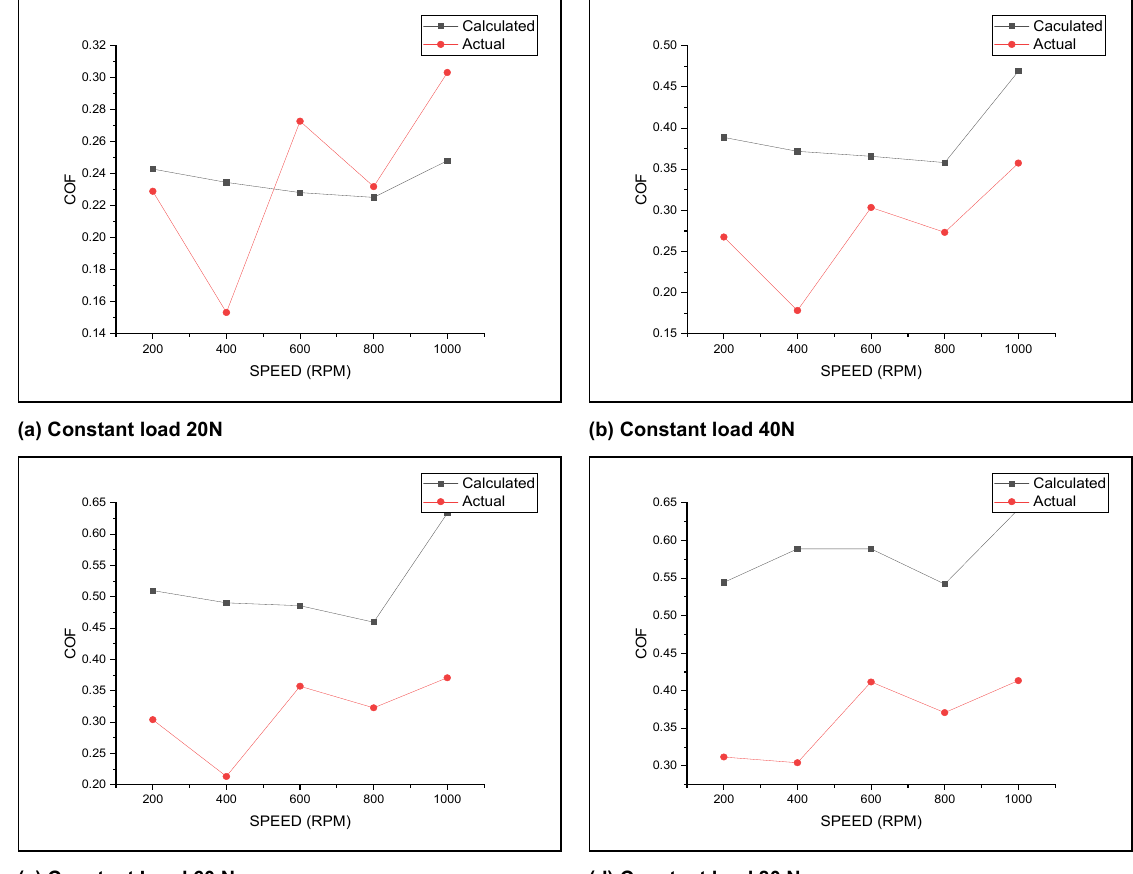
Figure 13.Comparison of COF for various RPM at constant load